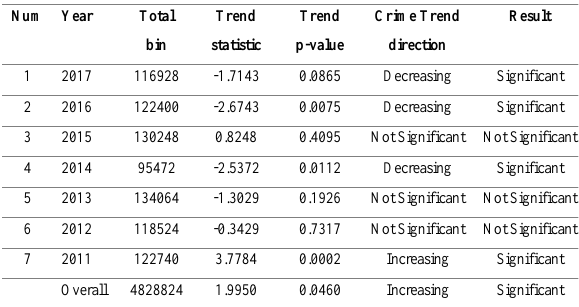
Table 2: Overall trend result by Space Time Cube (2011-2017)